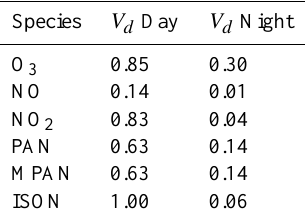
Table 1. Dry deposition velocities [cm s − 1 ] for species in the box model, which are the same as rainforest values for the global p- TOMCAT model.